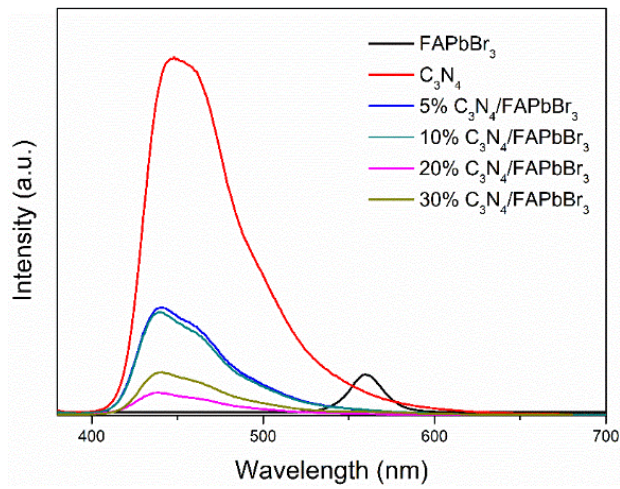
Figure 3. PL spectrum of FAPbBr 3 /C 3 N 4 hybrids materials with different weight ratio of FAPbBr 3 , g-C 3 N 4 and FAPbBr 3 .